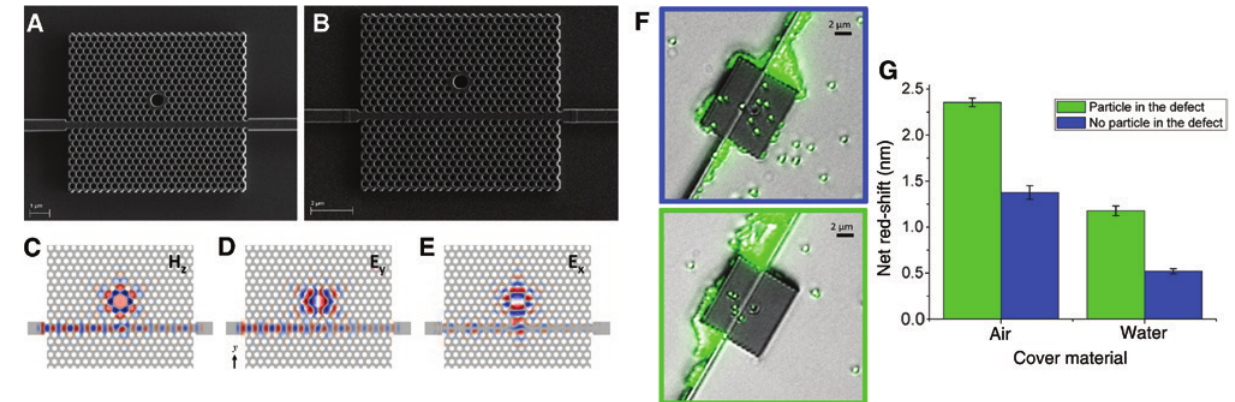
Figure 23: Photonic crystal nanocavities for biosensing of virus-sized particles under microfluidic flow. (A) and (B) SEM micrograph of two PhC sensors consisting of a triangular lattice with a point-like defect centred four and five rows away from the waveguide, respectively. (C)–(E) Numerically simulated electromagnetic field profiles of the device showing field localisation about the engineered hole defect. (F) Fluorescence microscopy images of the PhC sensor in the presence and absence of the fluorescent latex micro- sphere with the large engineered hole defect. (G) Corresponding net red shifts of the optical resonance wavelength. Adapted from [149].